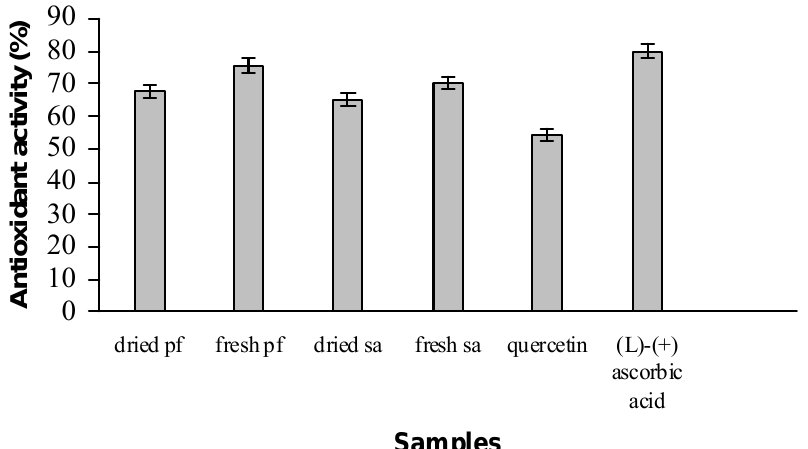
Figure 3 . Free radical-scavenging activity of extract samples at different concentration using ABTS ‘assay’. ( L )-(+) Ascorbic acid and quercetin were used as